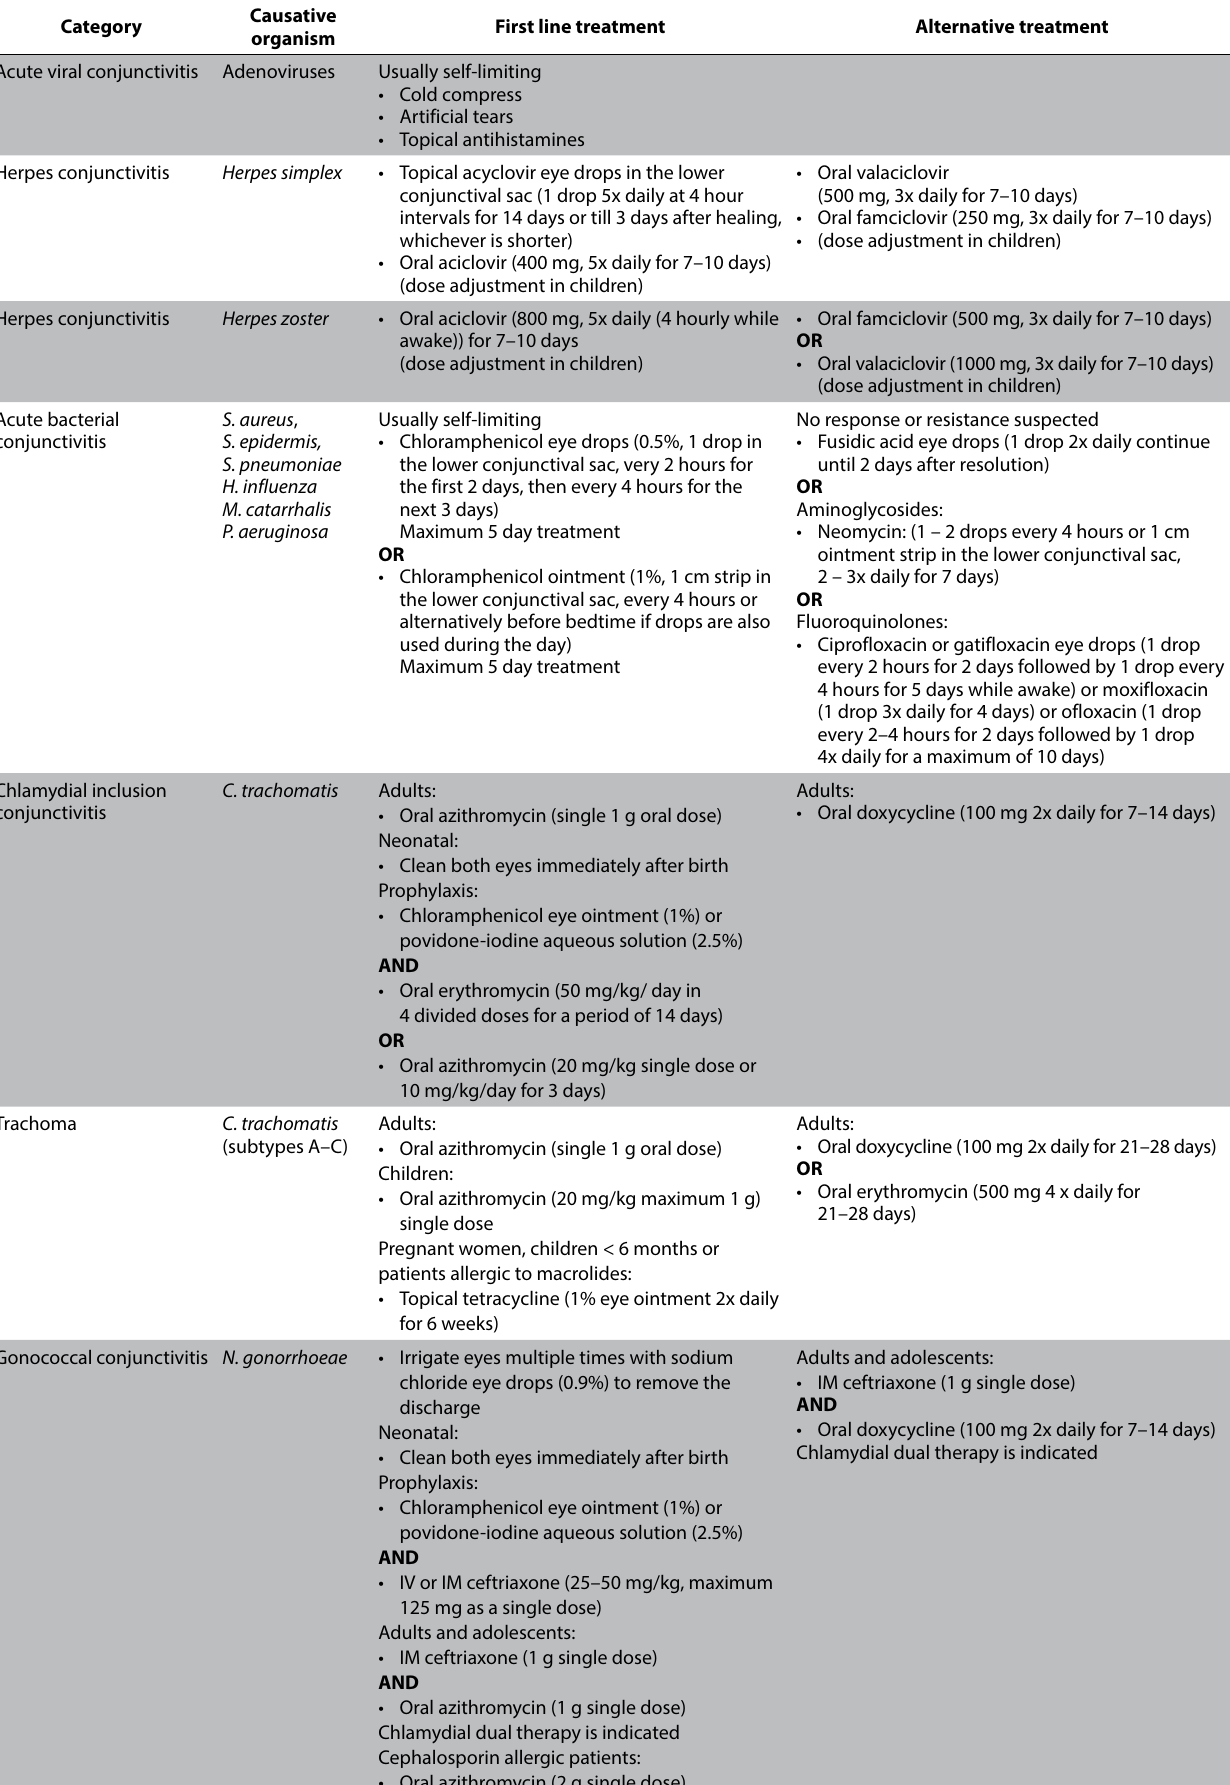
Table I. Pharmacotherapy for various types of conjunctivitis. 1-5,11,13,16-17,19,22,23,24,25,27